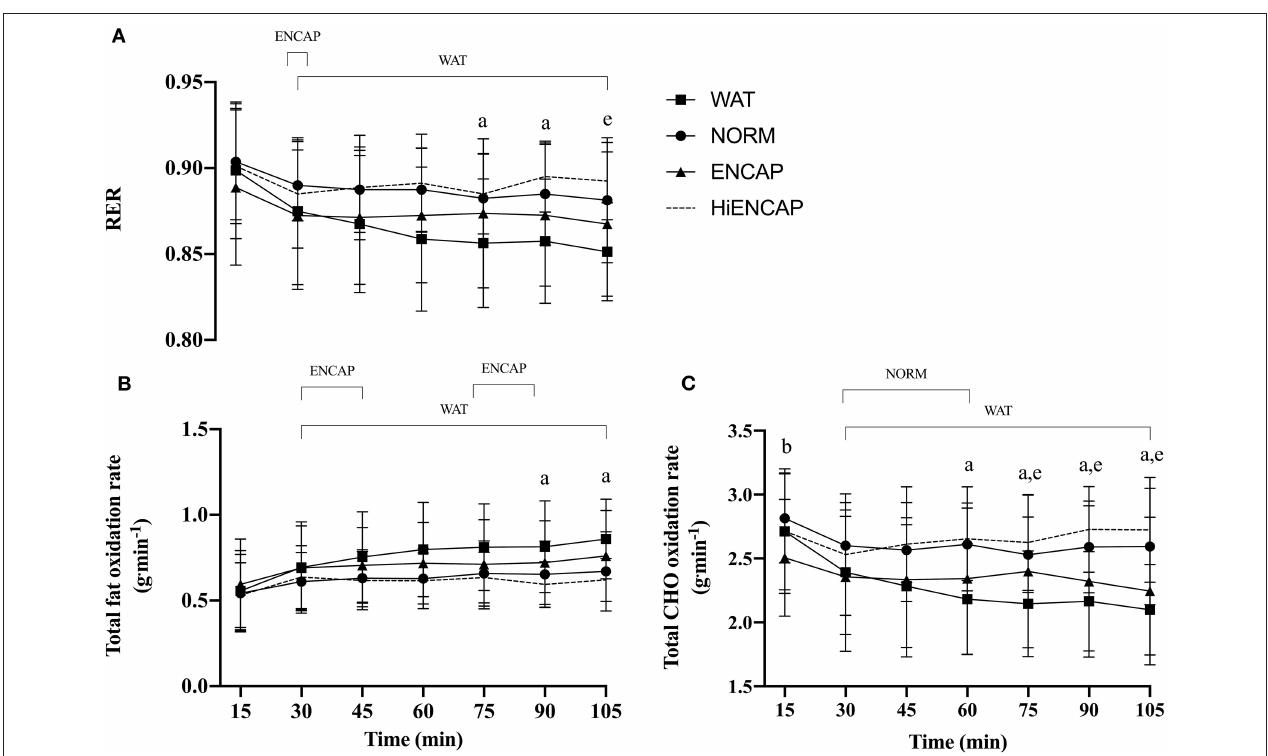
FIGURE 1 | RER (A) , total fat oxidation rate (B) , and total CHO oxidation rate (C) over the 105-min run between HiENCAP (dashed gray line), NORM (filled circles), ENCAP (filled triangles), and WAT (filled squares). a = significant difference between NORM and WAT, b = significant difference between NORM and ENCAP, and e = significant difference between WAT and HiENCAP. Time points that are significantly different from values at 15min are encompassed by a square bracket. n = 8. Values are mean ± SD.